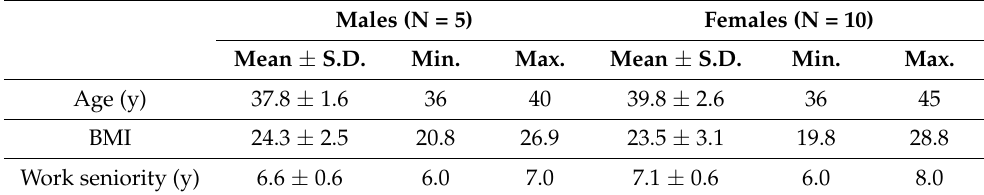
Table 1. Characteristics of the subjects